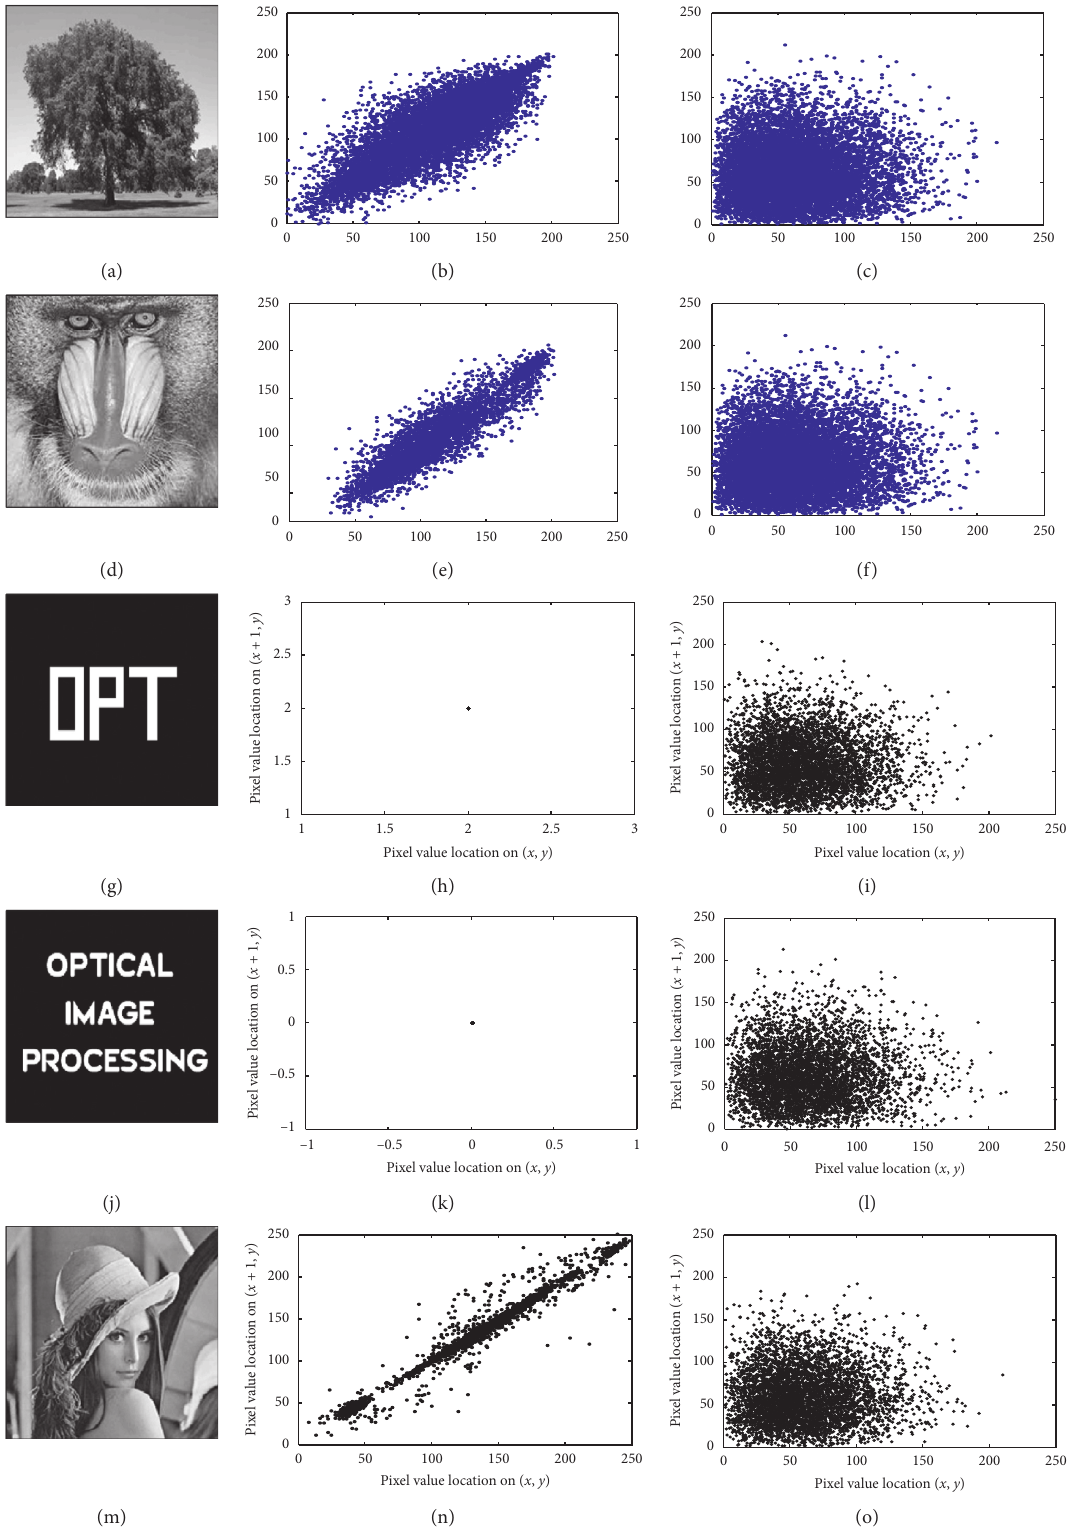
Figure 9: Plots of correlation distribution for randomly chosen 15,000-pixel pairs; (a, d, g, j, m) of input images; (b, e, h, k, n) correlation distribution of input images; (c, f, i, l, o) correlation distribution of encrypted